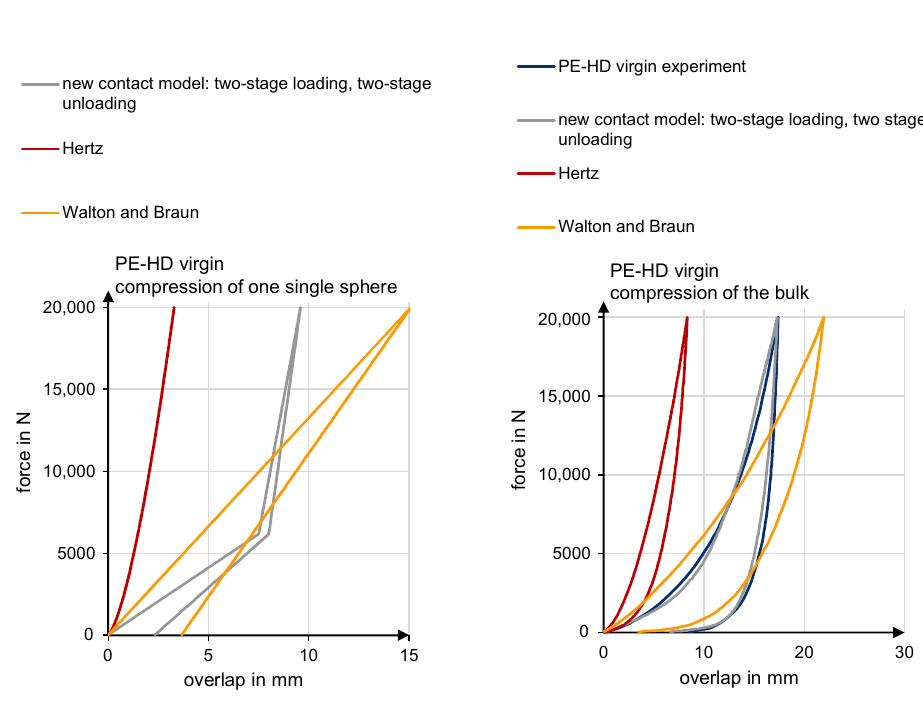
Figure 21. ( a ) General compression behavior of the contact models for one sphere; ( b ) compression behavior of the contact models for the bulk according to a compression test.